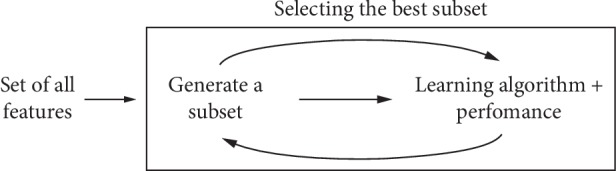
Embedded methods.